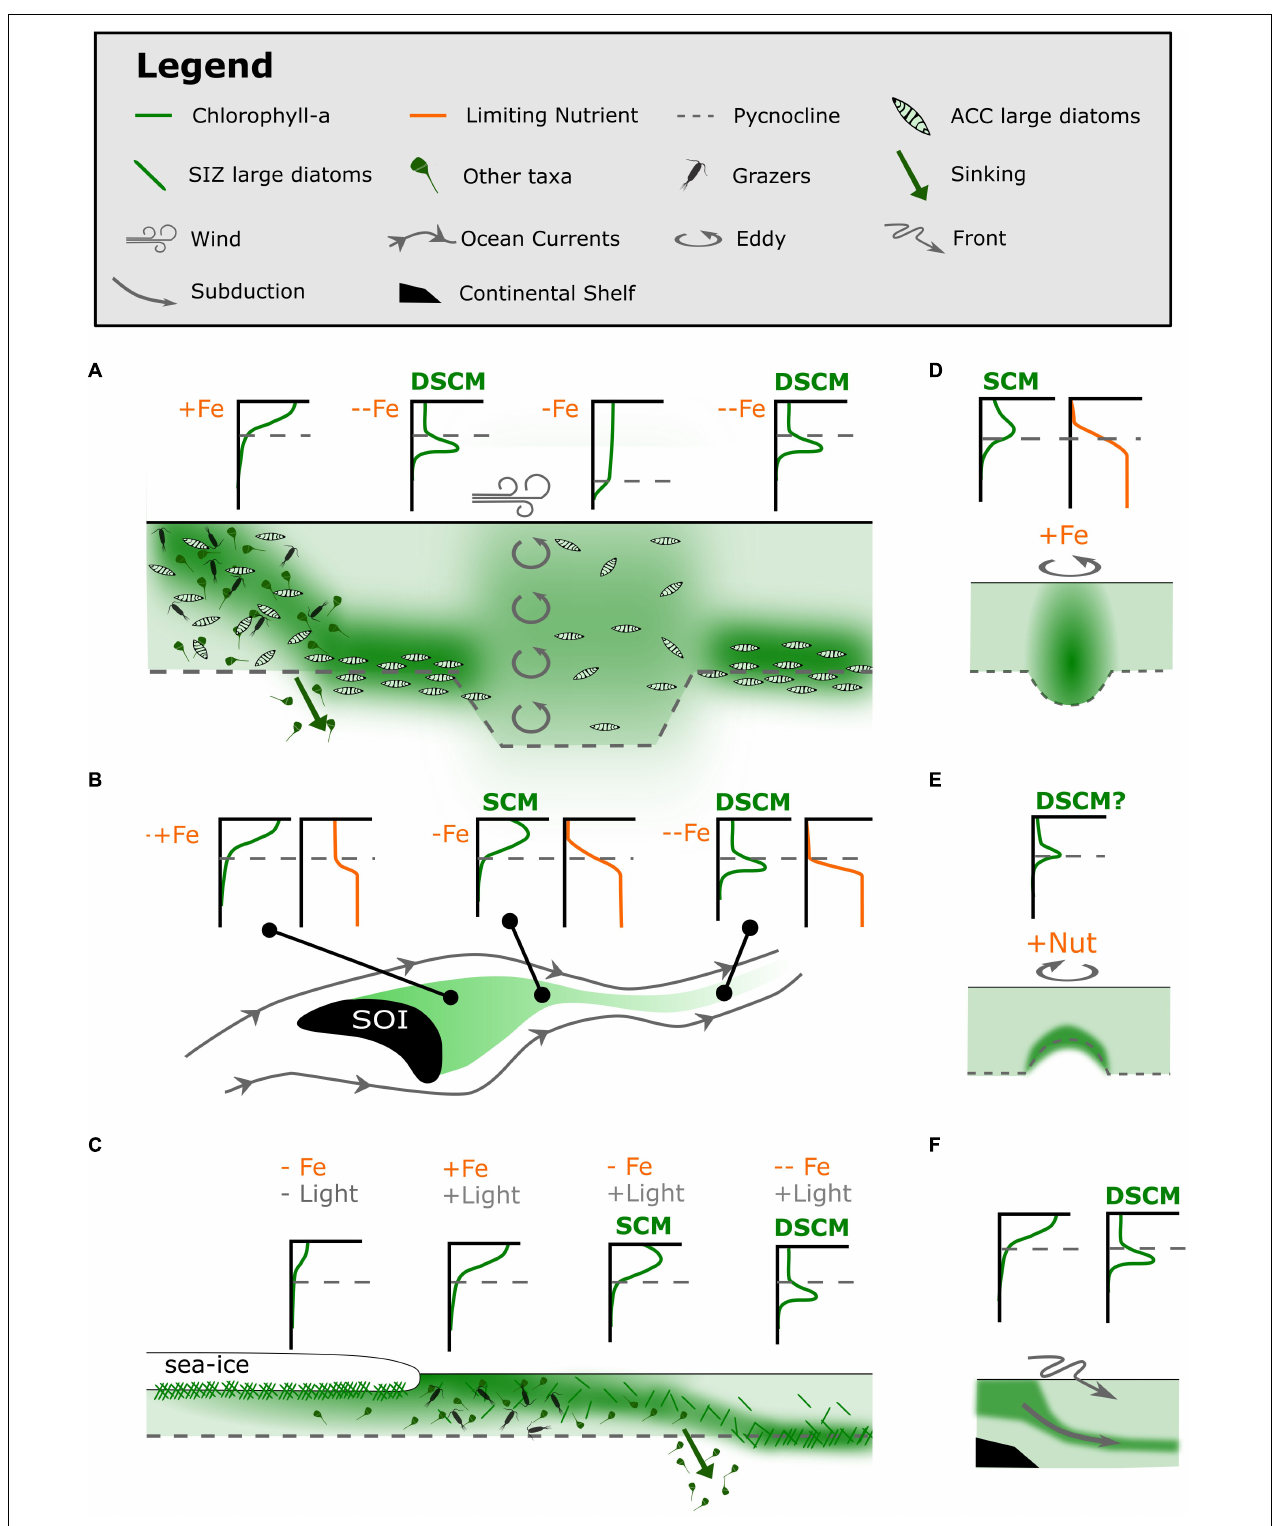
FIGURE 5 | Proposed conceptual models for the formation of Southern Ocean SCMs and diatom SCMs (dSCMs) (A) in the oceanic HNLC regions, (B) downstream of Southern Ocean Islands (SOI), (C) following sea-ice retreat, (D) in warm-core eddies in the Sub-Antarctic Zone, (E) in cold-core eddies in the Sub-Antarctic Zone and (F) by subduction along the continental shelf (as in Erickson et al., 2016). Conceptual models are presented as schematics, with examples of what vertical measurements of chlorophyll- a and limiting nutrients might look like.